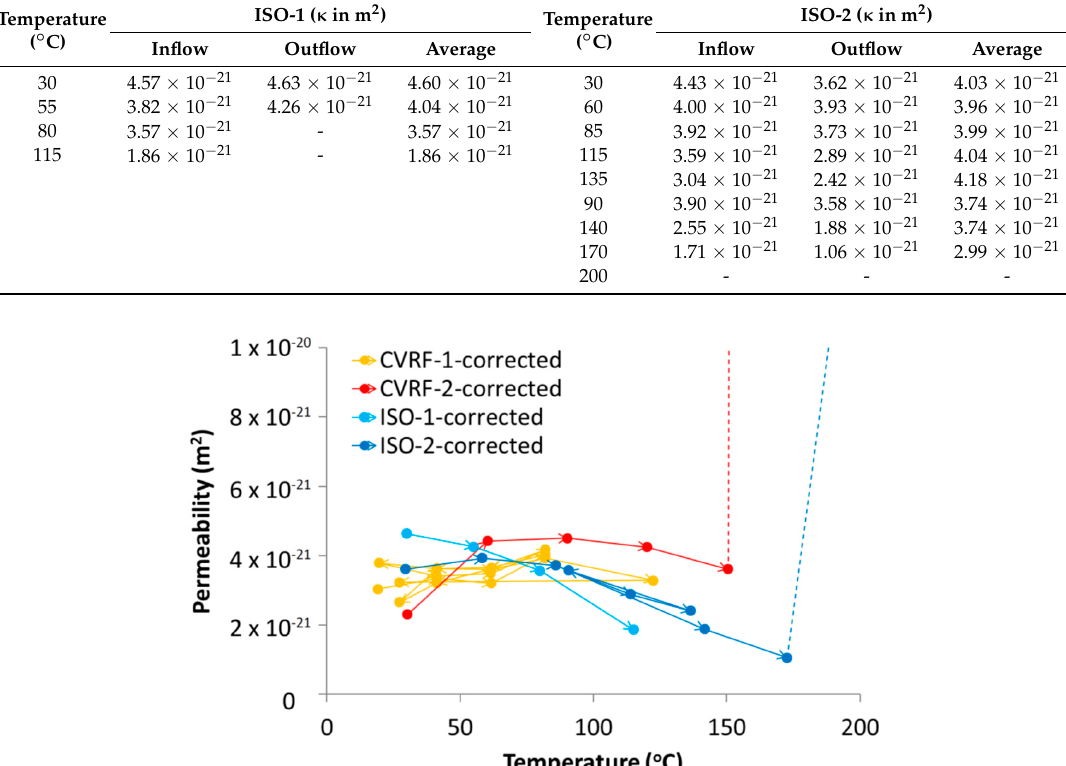
Table 5. Temperature and permeability data from ISO-1 and ISO-2 experiments.